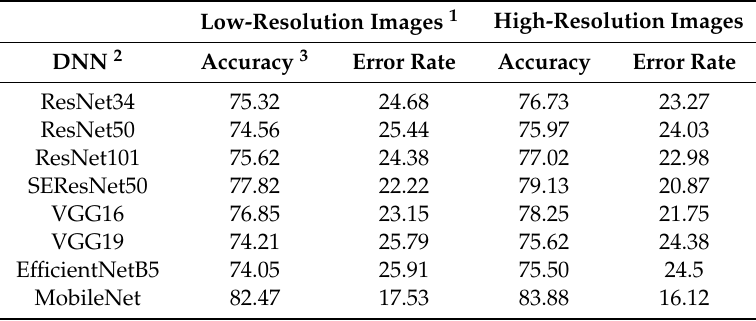
1 low-resolution image: 300 × 224 RGB; high-resolution image: 300 × 224 RGB. 2 Deep neural network. 3 accuracy and error rates are expressed as